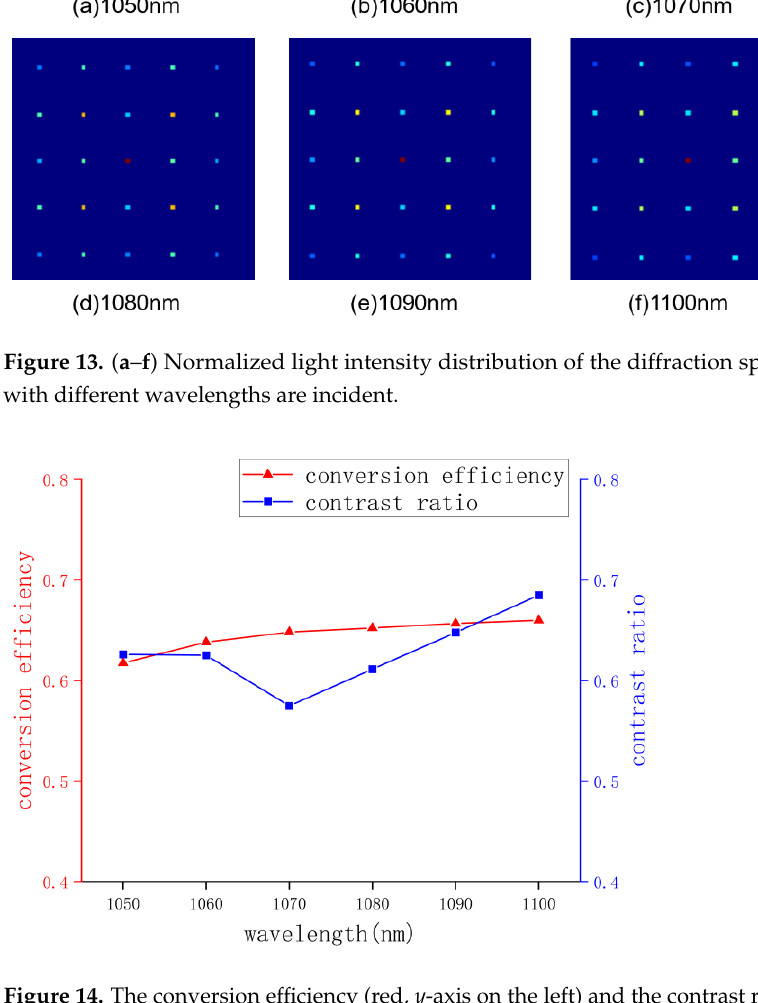
Figure 14. The conversion efficiency (red, y -axis on the left) and the contrast ratio (blue, y -axis on the right) of DG wavelengths from 1050 nm to 1100 nm.